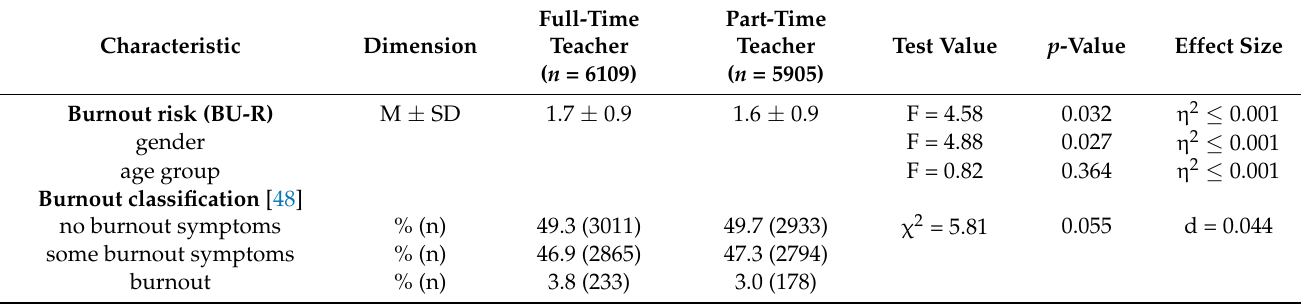
Table 3. Main effects of burnout risk and covariates and burnout classification of full-time and part-time teachers.